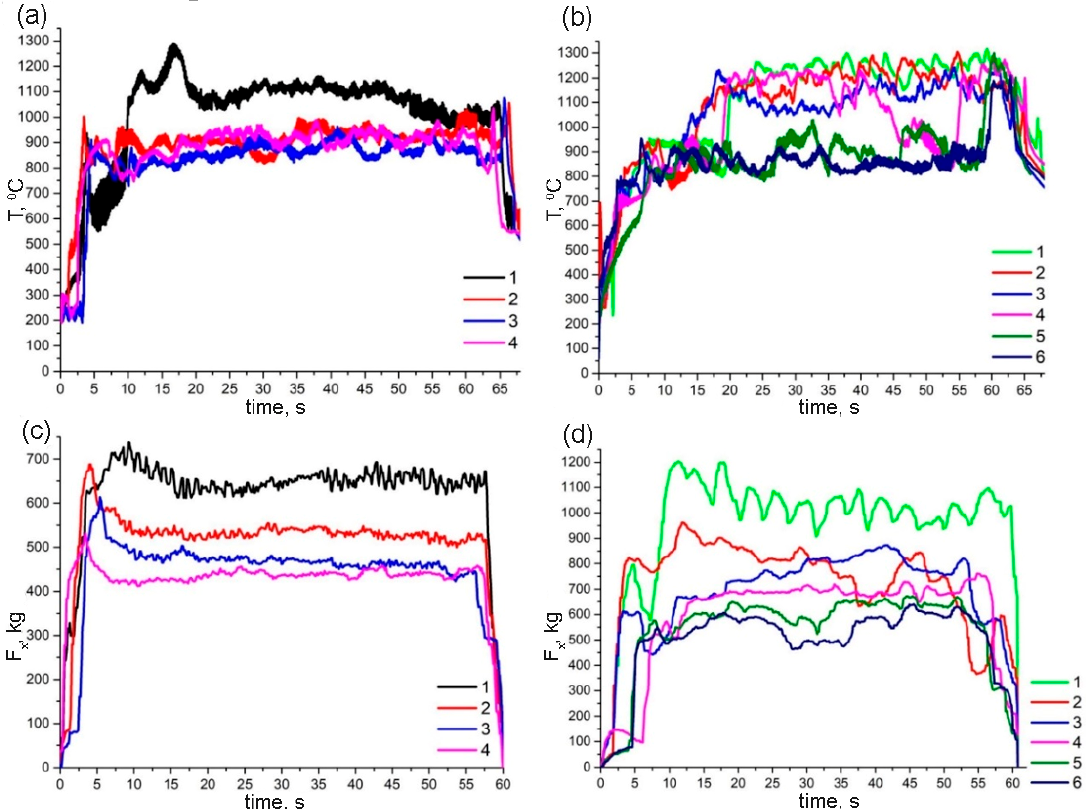
Figure 2. FSP temperature and resistance force dependencies on time for 1–4-pass FSP on Ti6Al4V ( a , c ) and 1–6-pass FSP on Ti6Al4V/Cu ( b , d ). Each of the FSP pass times was limited to that of the shortest last pass.